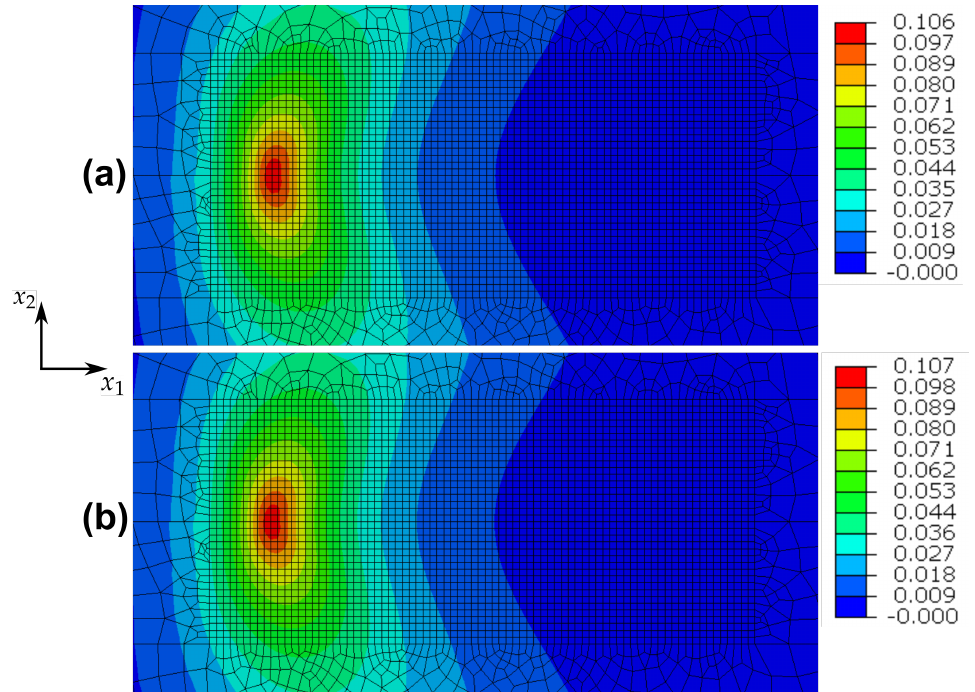
Figure 5. Pure kinematic hardening: damage evolution for the cracked specimen after ( a ) one loading cycle and after ( b ) ten loading